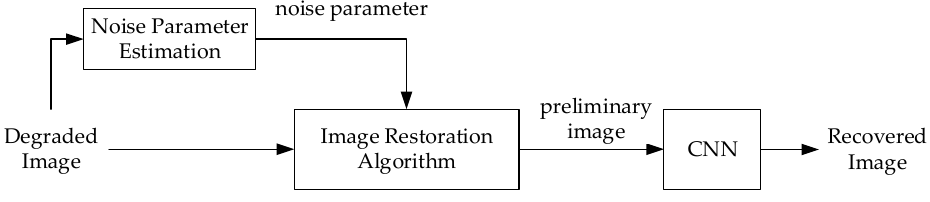
Figure 1. Overall architecture of the algorithm.